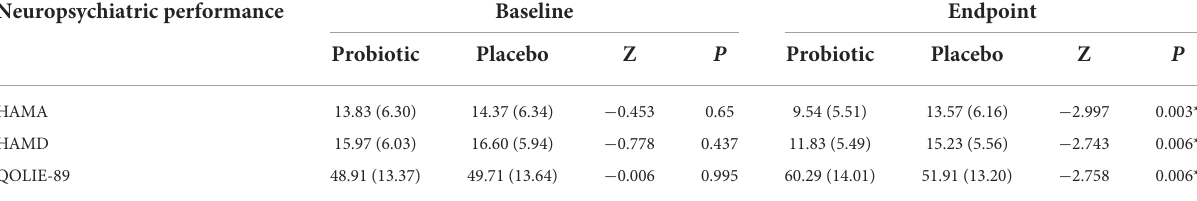
TABLE 3 Neuropsychological investigation of participants.